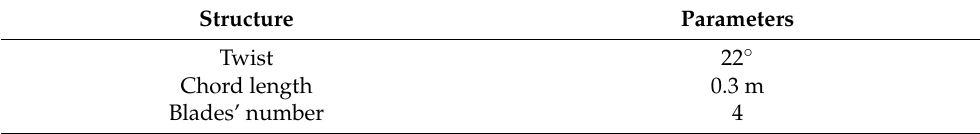
Table 7. Structural parameters of the rotor disk.